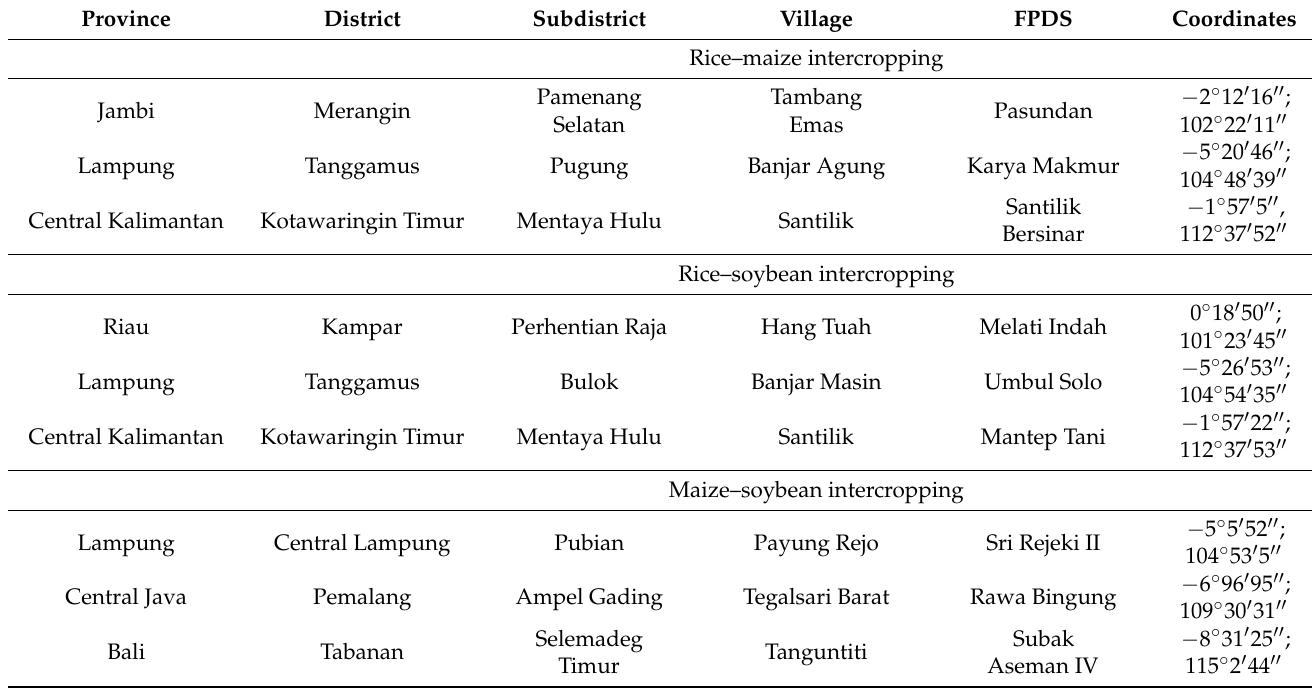
Table 1. Location and farmer participatory demonstration sites (FPDSs) of rice–maize, rice–soybean, and maize–soybean intercropping systems in rainfed areas of western Indonesia with a wet climate,